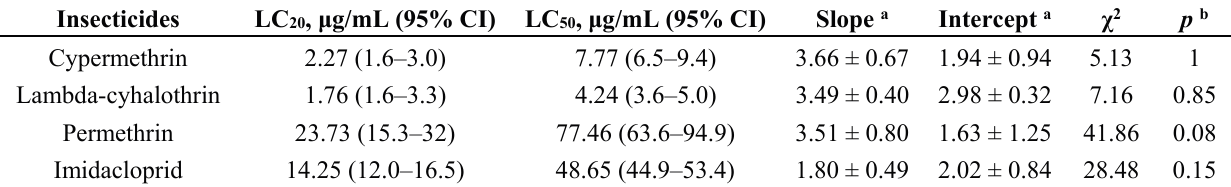
Table 2. Summary of the lethal concentrations to kill 20% (LC20) and 50% (LC 50 ) of the insect population, and their 95% confidence intervals (95% CI) for each of the four insecticides determined in 20-day larvae of T. castaneum (Georgia-1